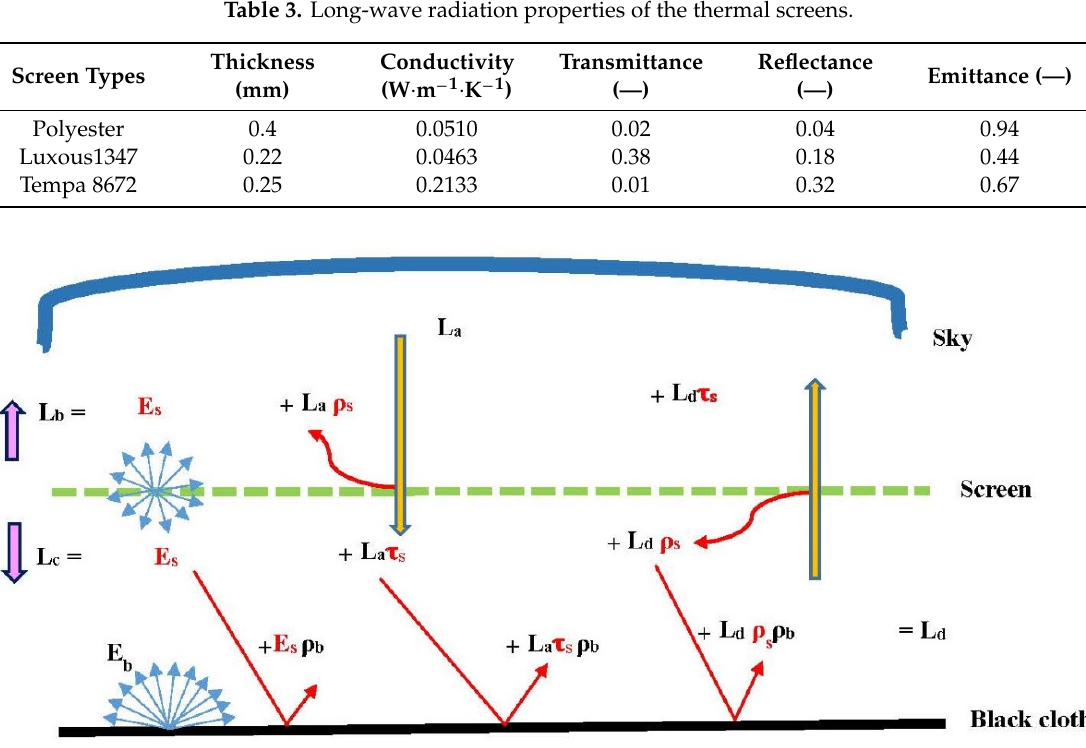
Figure 5. Schematic diagram of the setup to measure used screen’s radiometric properties.